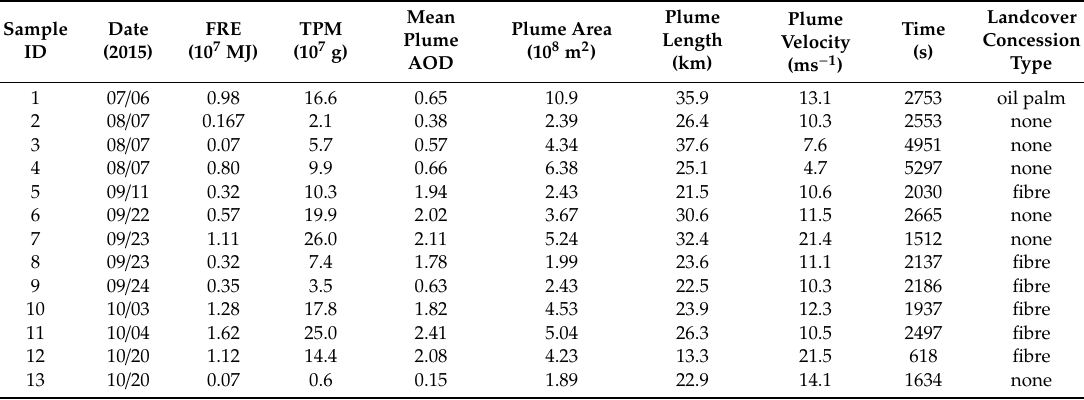
Table 1. Key statistics for the thirteen matchup fires shown in Figure 2 and used to derive the total particulate matter (TPM) smoke emissions coe ffi cient ( C e ) in Figure 3. Data for the plume subsets and the fires contained within the plume polygon depicted in Figure 2 are